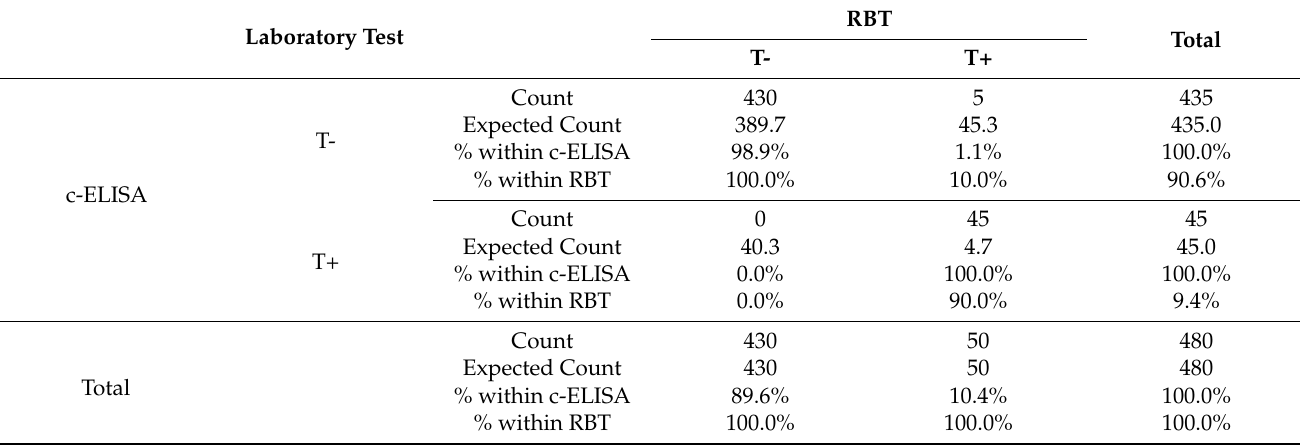
Table 4. c-ELISA vs. RBT cross